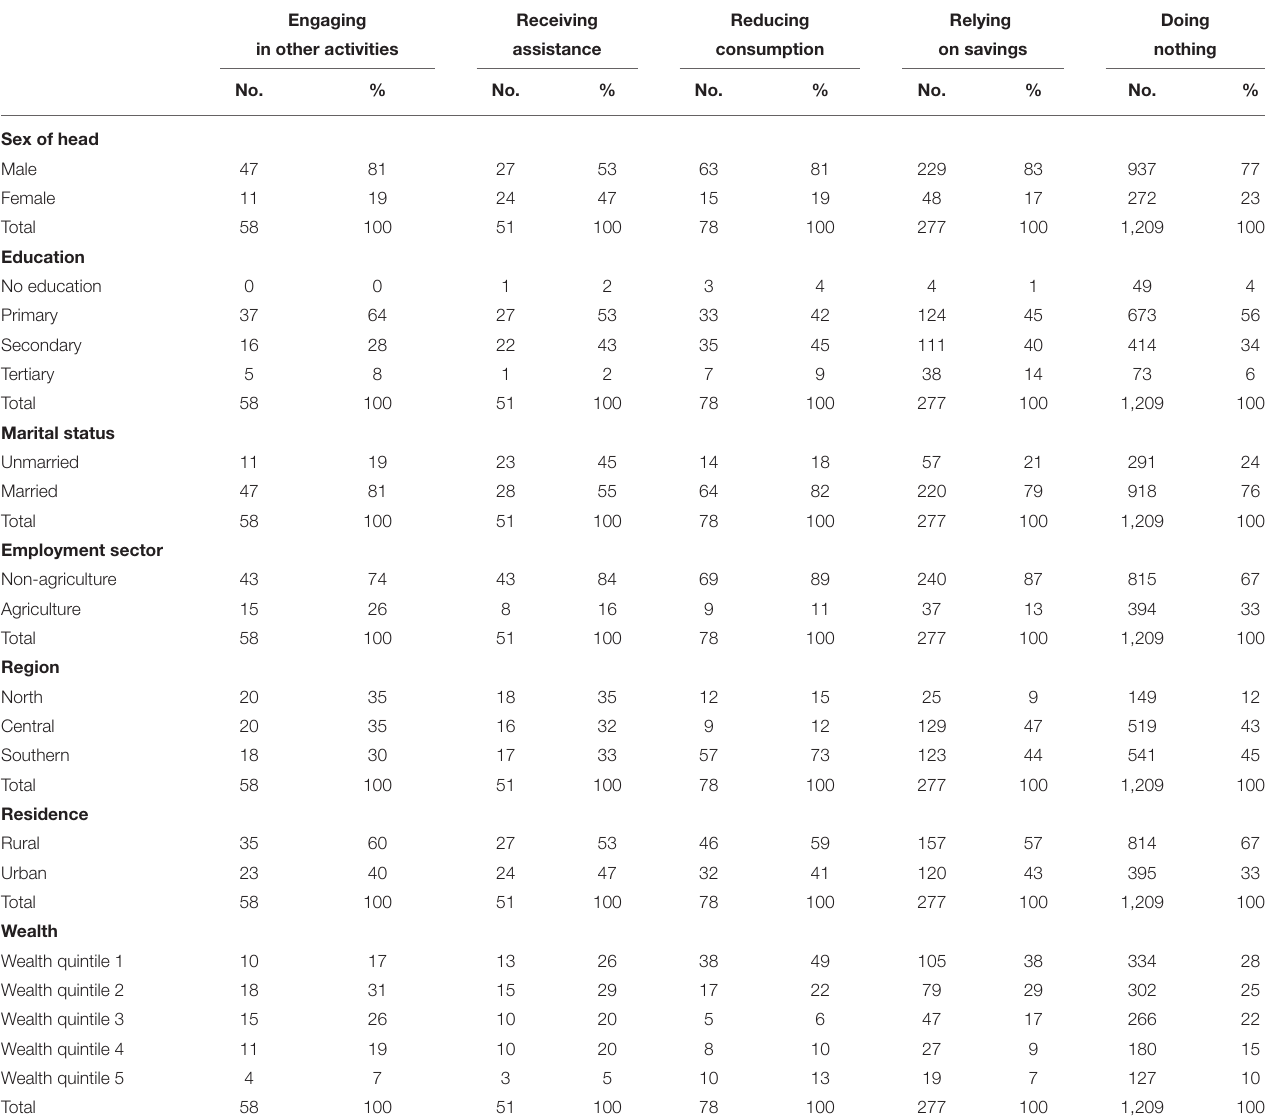
TABLE 2 | Distribution of coping